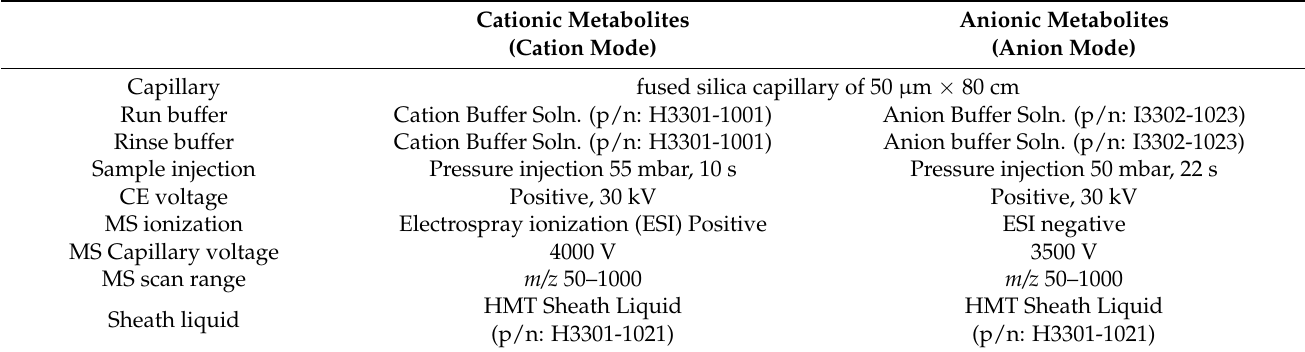
Table 3. Conditions of CE-TOF/MS analysis (cation and anion